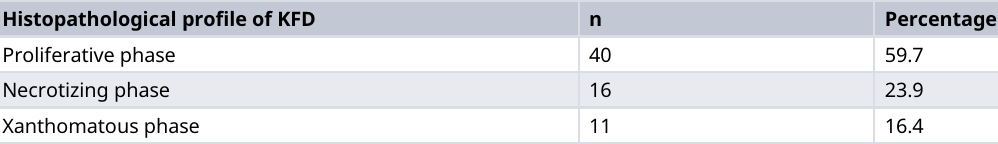
Table 3. Histopathological profile of Kikuchi Fujimoto disease patients (n=67).